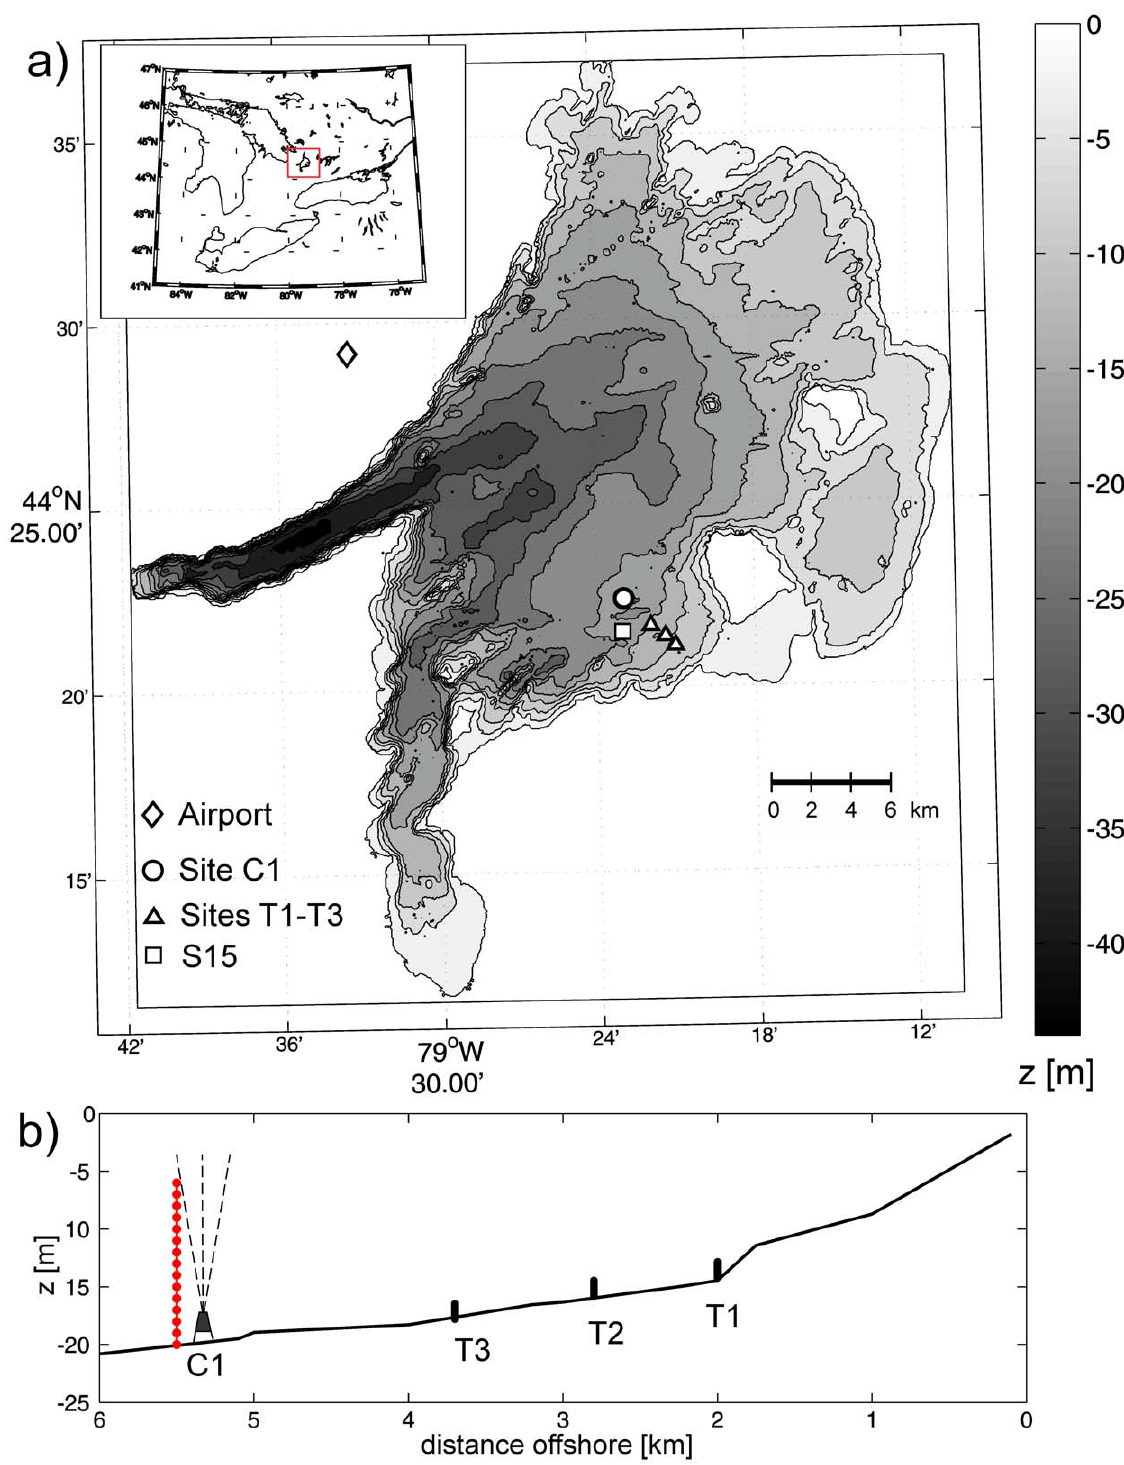
Figure 1. Field experiment location and bathymetry of Lake Simcoe, Ontario (Canada). a) Bathymetry of Lake Simcoe. Four thermistor chains were arranged in a cross-shelf transect, to depths between 20 m and 12 m (contours shown in m). An acoustic Doppler current profiler (ADCP) was located next to the 20 m mooring. Also shown is the location of Barrie Airport (weather station) and the long term MOE monitoring site S15. b) Alignment of four thermistor chains (C1, T1–T3) and the ADCP in the cross-shelf transect of the southern shore of Lake Simcoe.